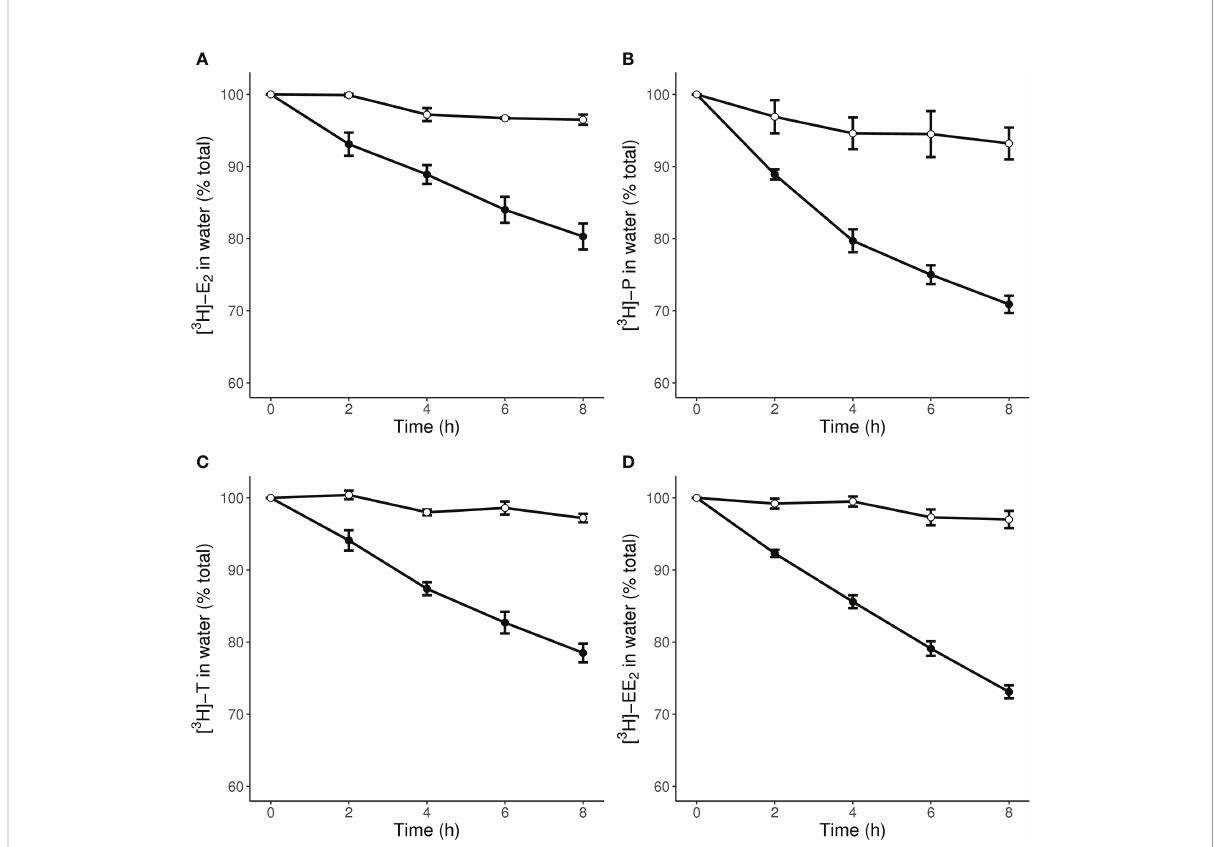
FIGURE 1 Radioactive steroid removal from water by L. stagnalis during an 8 h exposure to a concentration of 2.6 µCi L -1 [ 3 H]-E 2 (A) , 2.7 µCi L -1 [ 3 H]-P (B) , 3.5 µCi L -1 [ 3 H]-T (C) , and 2.7 µCi L -1 [ 3 H]-EE 2 (D) . Exposure ( ● ) and sorption control ( ○ ) data are presented as mean % total ± S.E.M (n=5 exposure vessels with 2 animals each and n=3 control